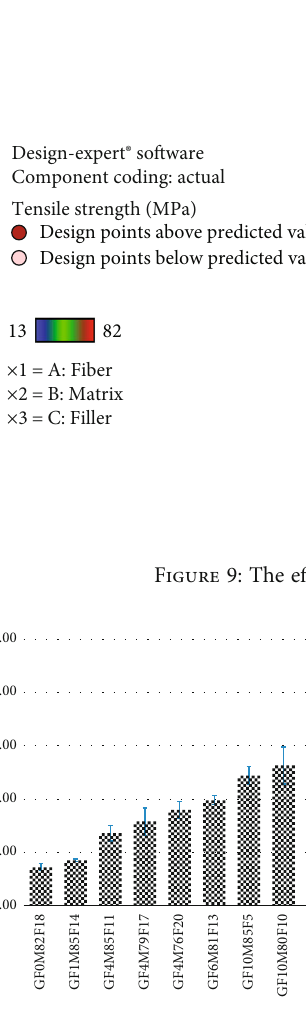
Figure 10: The maximum of average compressive strength of